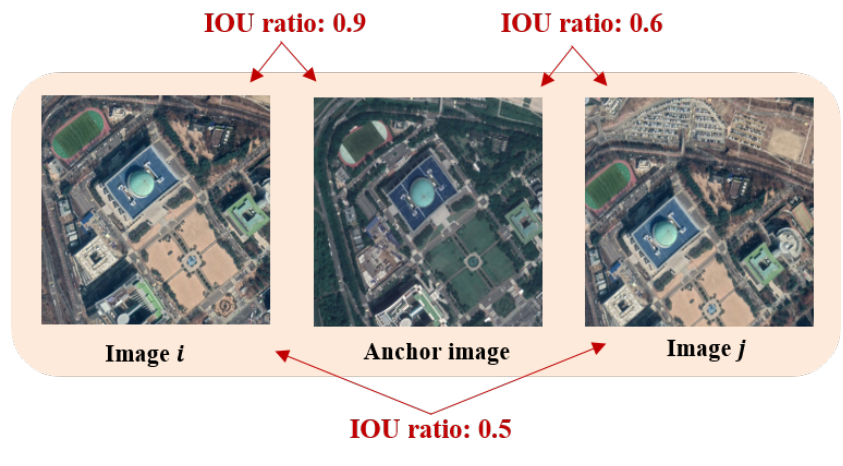
Figure 7. Data tuple example of Step 2. The data tuples consist of the anchor image, image i , and image j . All images were taken from the same area but had different variables during